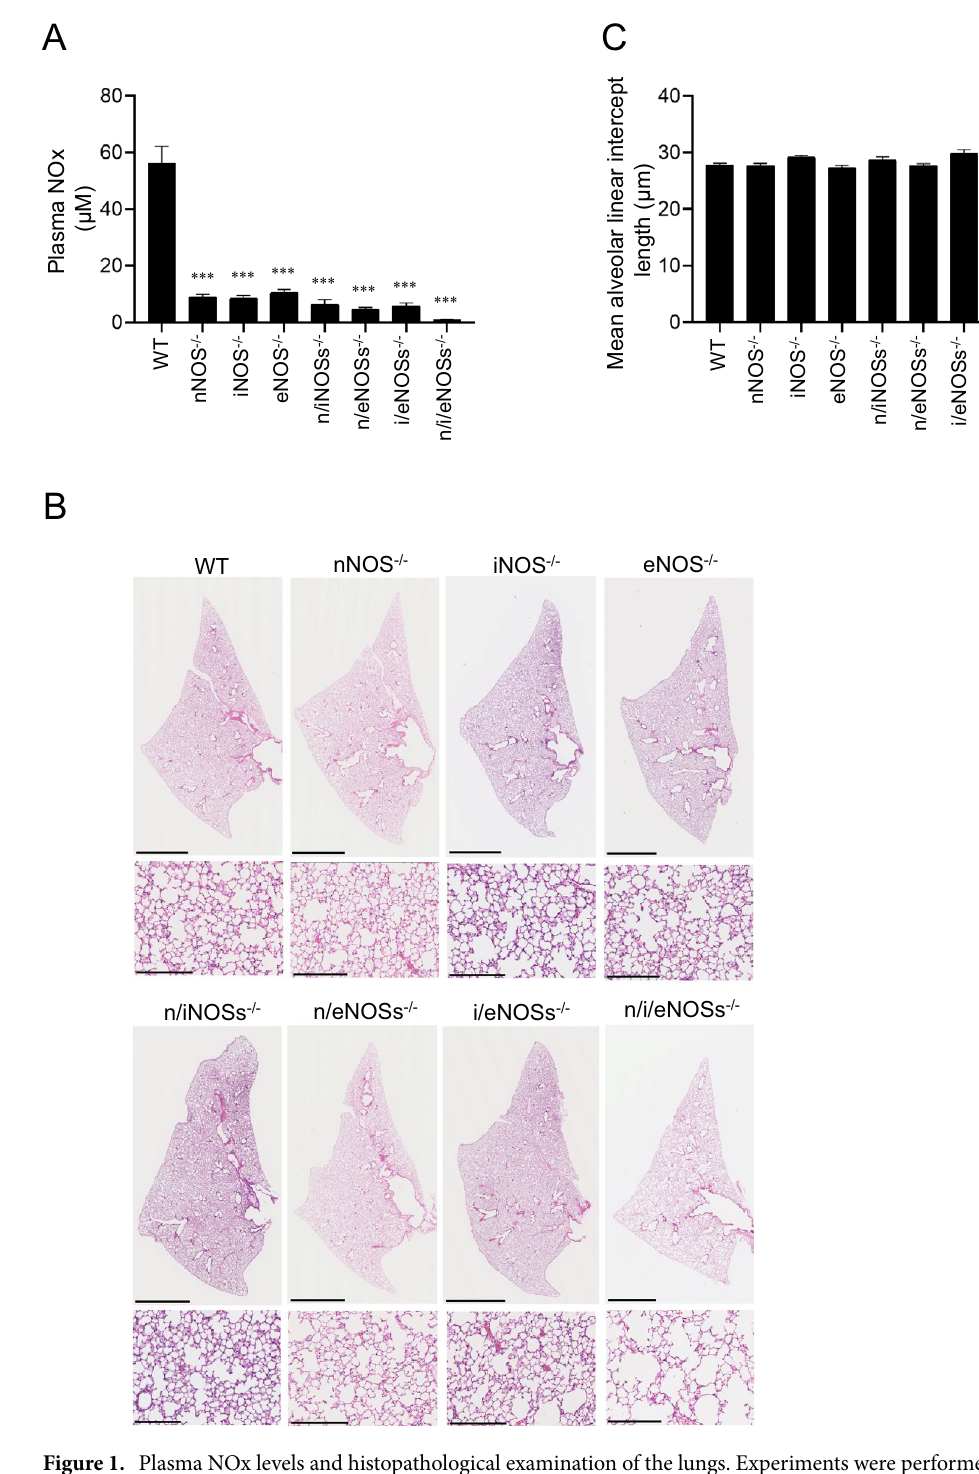
Figure 1. Plasma NOx levels and histopathological examination of the lungs. Experiments were performed in 8-week-old male WT and single, double, and triple NOSs −/− mice. (A) Plasma NOx levels. *** P < 0.001 vs. WT mice (n = 9–10). (B) Hematoxylin and eosin staining of lung tissues. Scale bars in upper and lower pictures indicate 2,500 and 250 μm, respectively. (C) The mean alveolar linear intercept length (n = 9–10). *** P < 0.001 vs. WT mice. (D) Hematoxylin and eosin staining of lung tissues in WT and triple n/i/eNOSs −/− mice. Arrowheads indicates destroyed alveoli. Scale bar = 50 μm. (E) The alveolar destructive index (n = 5 each) *** P < 0.001 vs. WT mice. (F) Elastic van Gieson (EVG) staining of lung tissues. Arrowheads indicate EVG staining-positive elastic fibers (black color). Scale bars represents 50 μm. (G) Lung elastic fiber content as estimated by the lengths of EVG staining-positive elastic fibers (n = 4 each). ** P < 0.01 vs. WT